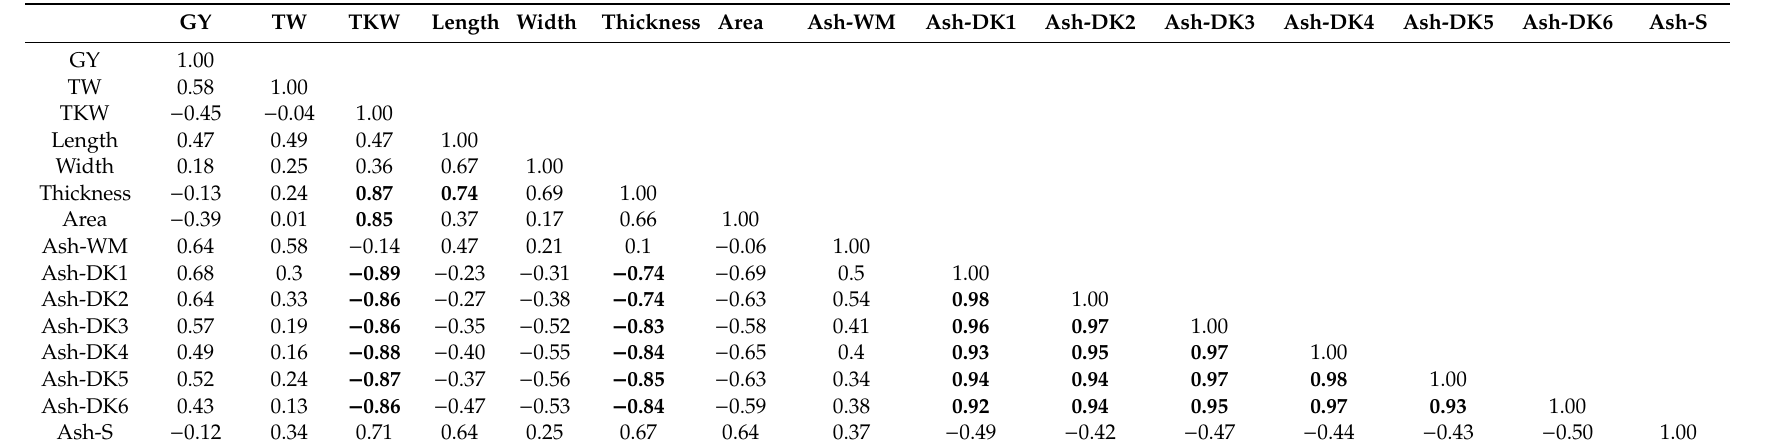
Table 2. Correlations among morphological and productive traits and